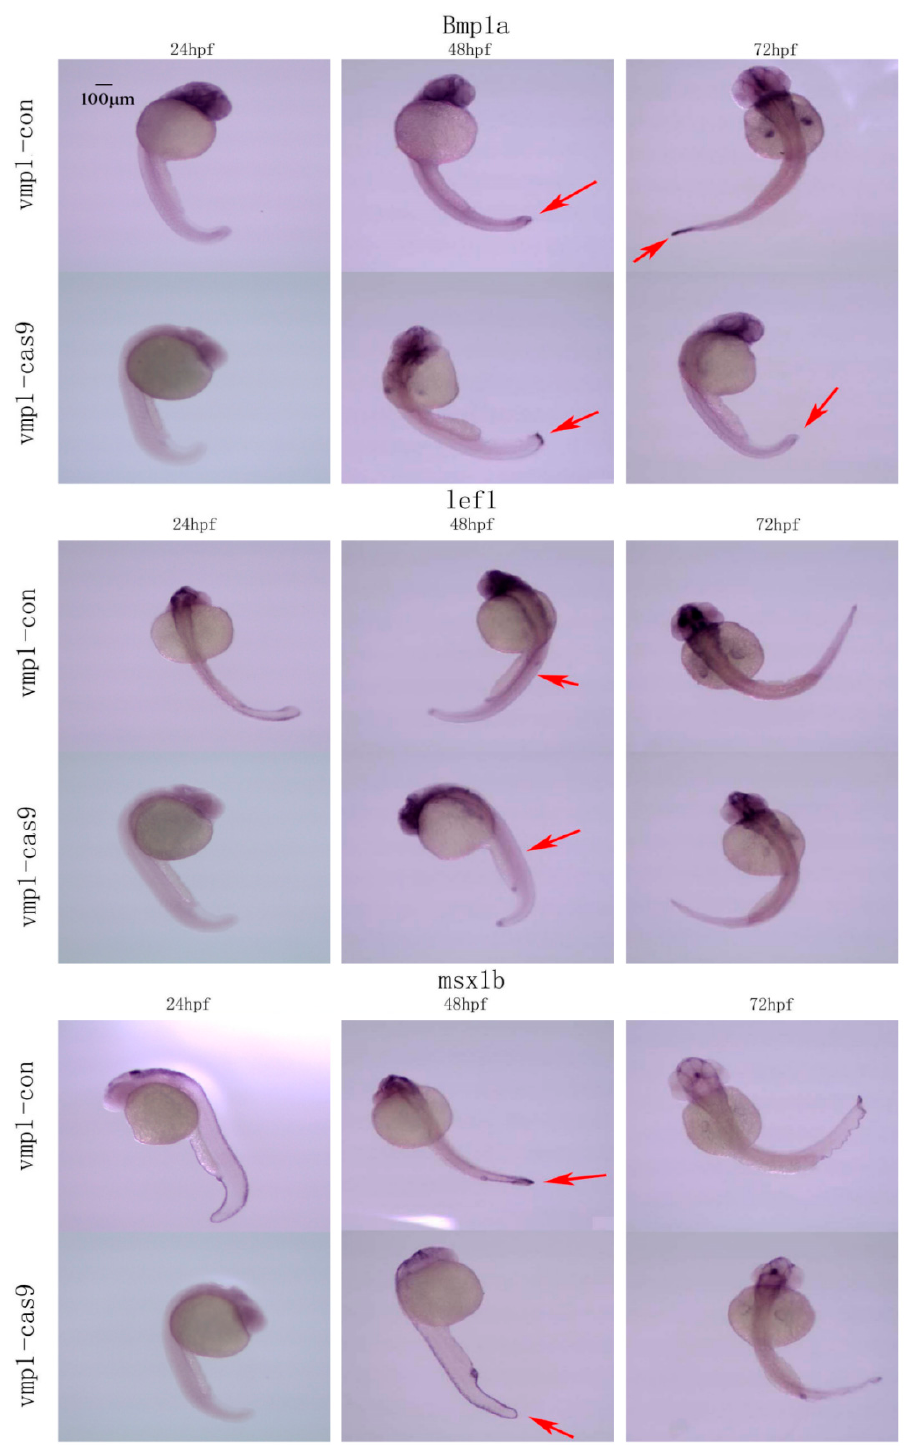
Figure 14. The temporal and spatial expression of marker genes related to caudal fin regeneration in 24–72 hpf embryos after lincRNA-154324 gene knockout. Bmp1a , lef1 , and msx1b spatial expres- sion in the lincRNA-154324-con and lincRNA-154324-cas9 groups at different stages of zebrafish embryogenesis. Red arrows: pointing to the site of gene expression. Scale bars: 100 μ m.